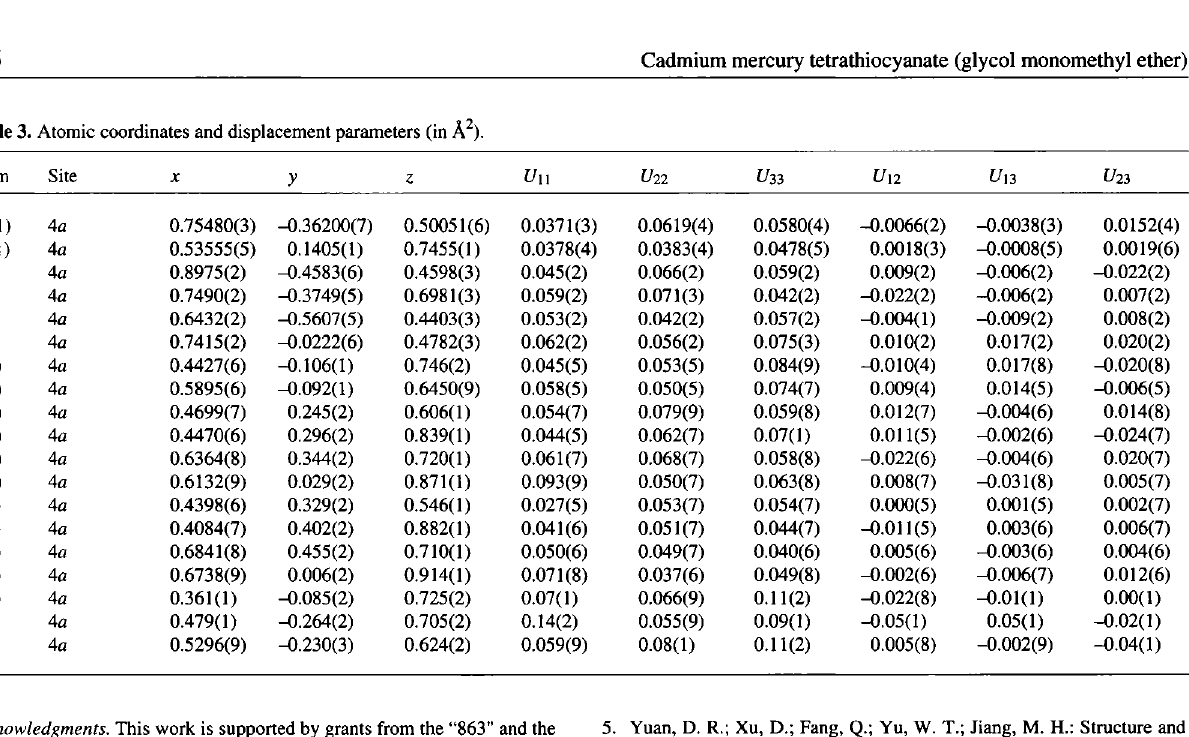
Table 3. Atomic coordinates and displacement parameters (in Ä 2